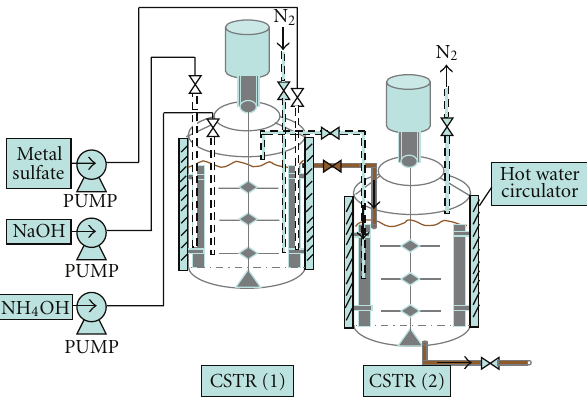
Figure 1: Schematic of device for preparing [Ni 0 . 5 Mn 0 . 3 Co 0 . 2 ] (OH) 2 precursor by continuous